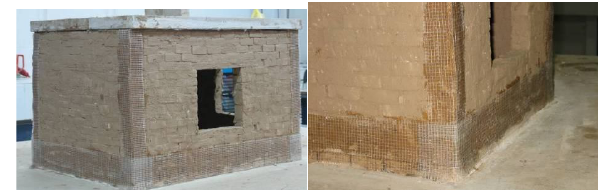
Fig. 12. Failure of specimen CF2.